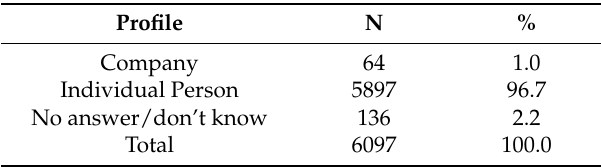
Table 5. Downloads by individual or company.